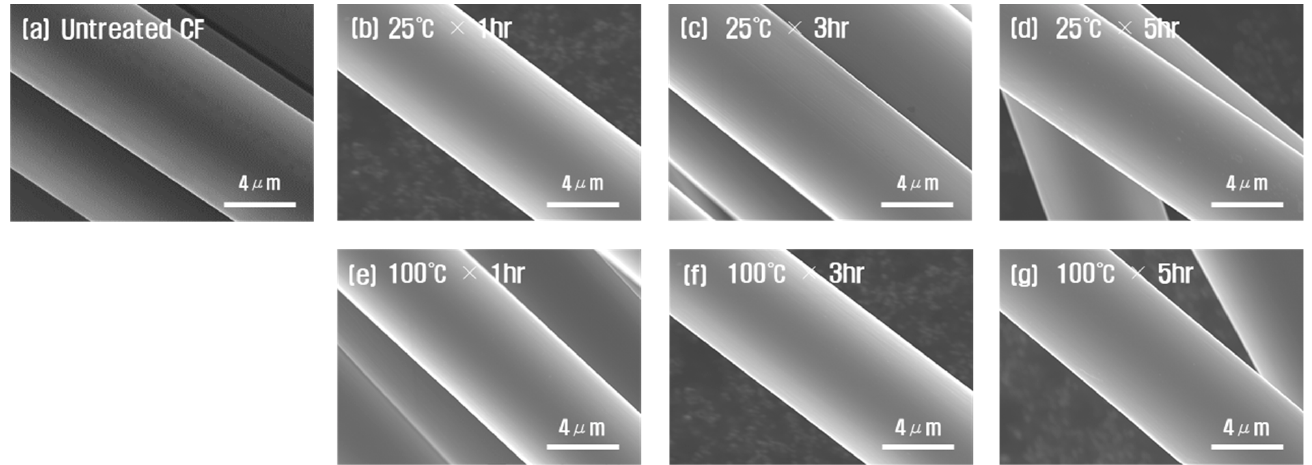
Figure 1. SEM photographs of carbon fibers according to chemical treatment conditions: ( a ) untreated CF, ( b ) 1 h, ( c ) 3 h, ( d ) 5 h at 25 °C and ( e ) 1 h, ( f ) 3 h, ( g ) 5 h at 100 °C.